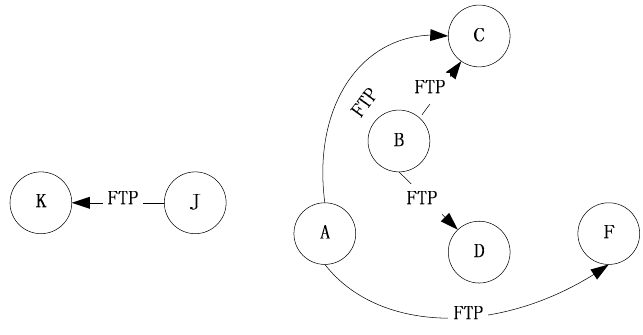
Figure 6. Abstract simulation scenario of the ship ad hoc network.